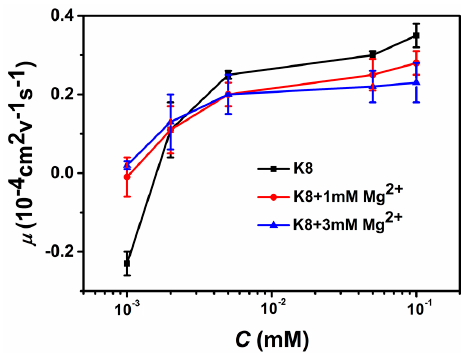
Mg 2+ ) in 1 mM TRIS solution.